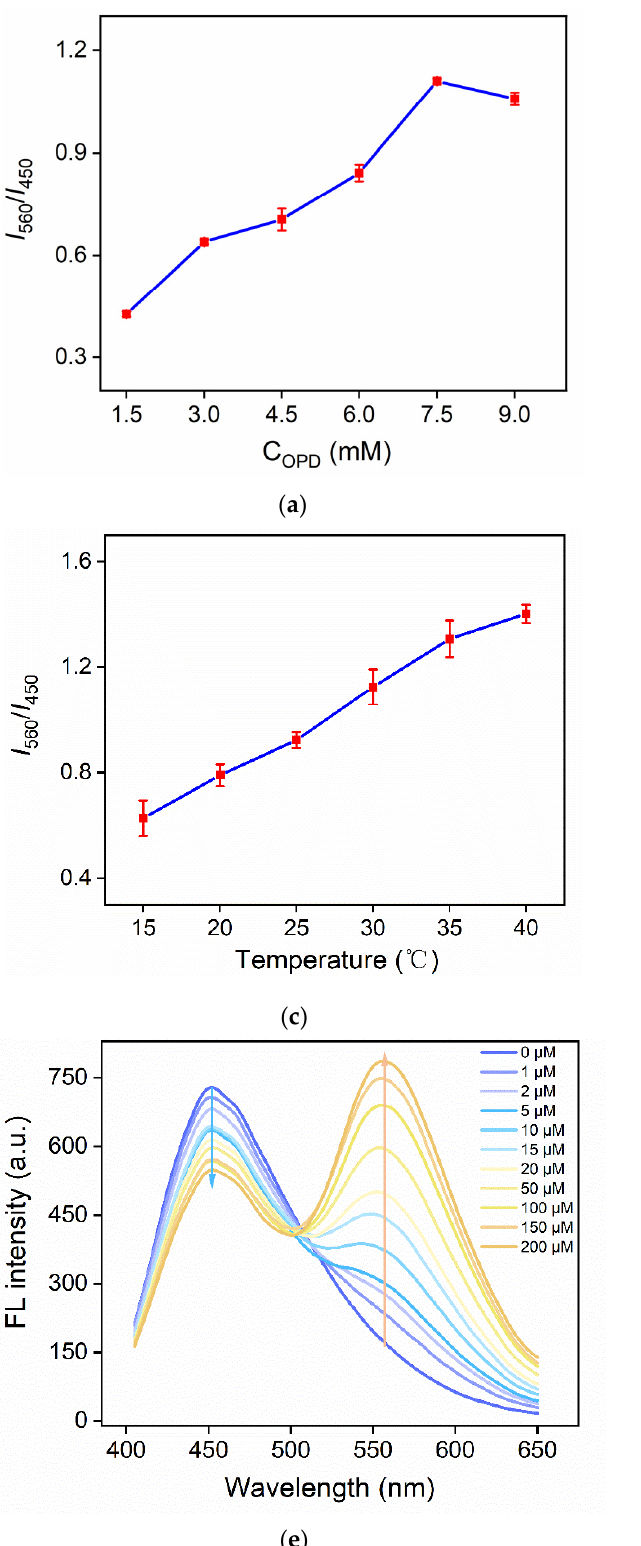
Figure 7. The effect of OPD concentration ( a ), pH ( b ), temperature ( c ), and reaction time ( d ) on I 560 / I 450 signals. I 560 and I 450 represent fluorescence intensity at 560 nm or 450 nm, respectively. ( e ) The fluorescence emission spectra of OPD + CDs solution in the presence of different concentrations of H 2 O 2 . The excitation wavelength was 390 nm. ( f ) The regression curve between I 560 /I 450 and the logarithmic value of hydrogen peroxide concentration.